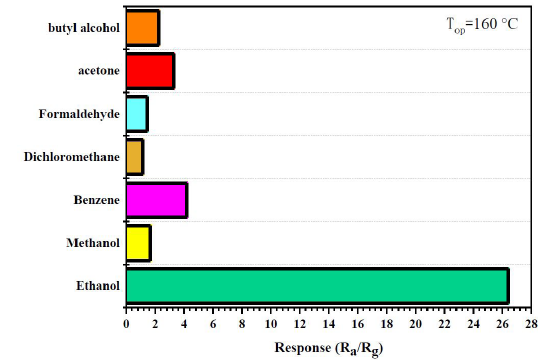
-5 gas sensor under different 3